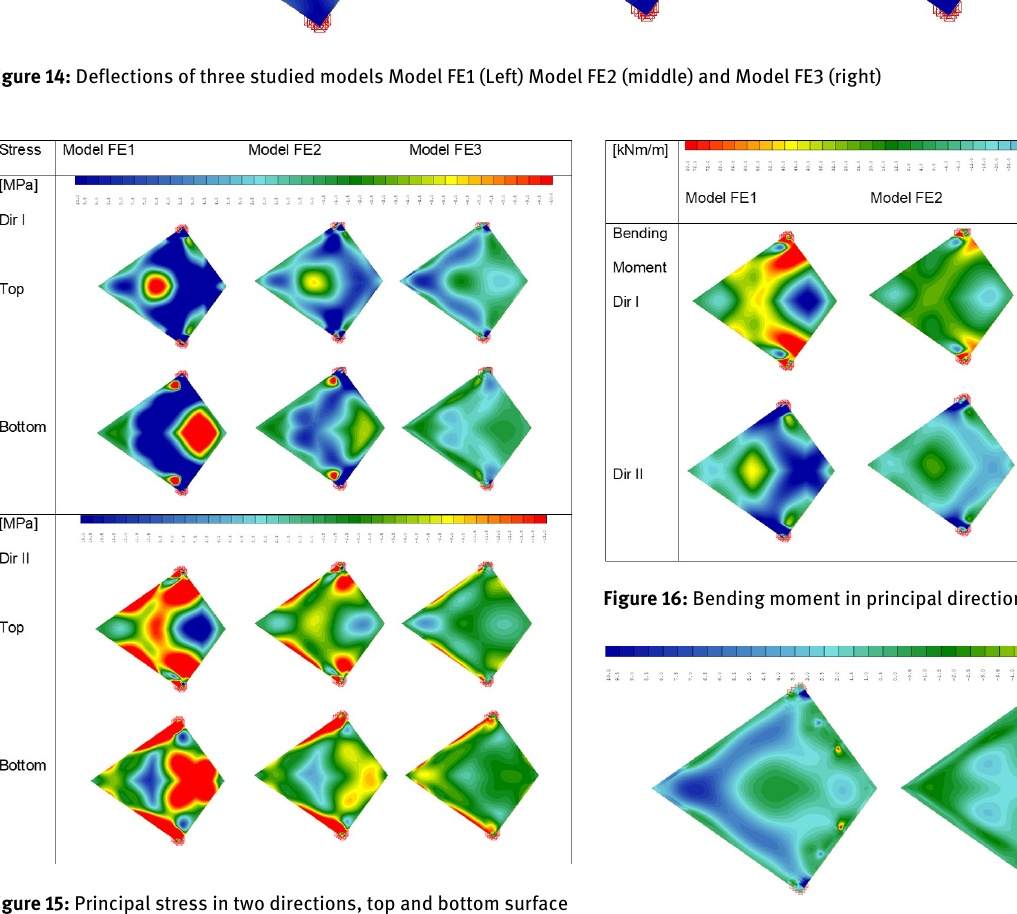
Figure 17: Principal stress in direction I of model FE4, top and bot- tom surface Figure 18: Principal stress in direction II of model FE4, top and bottom